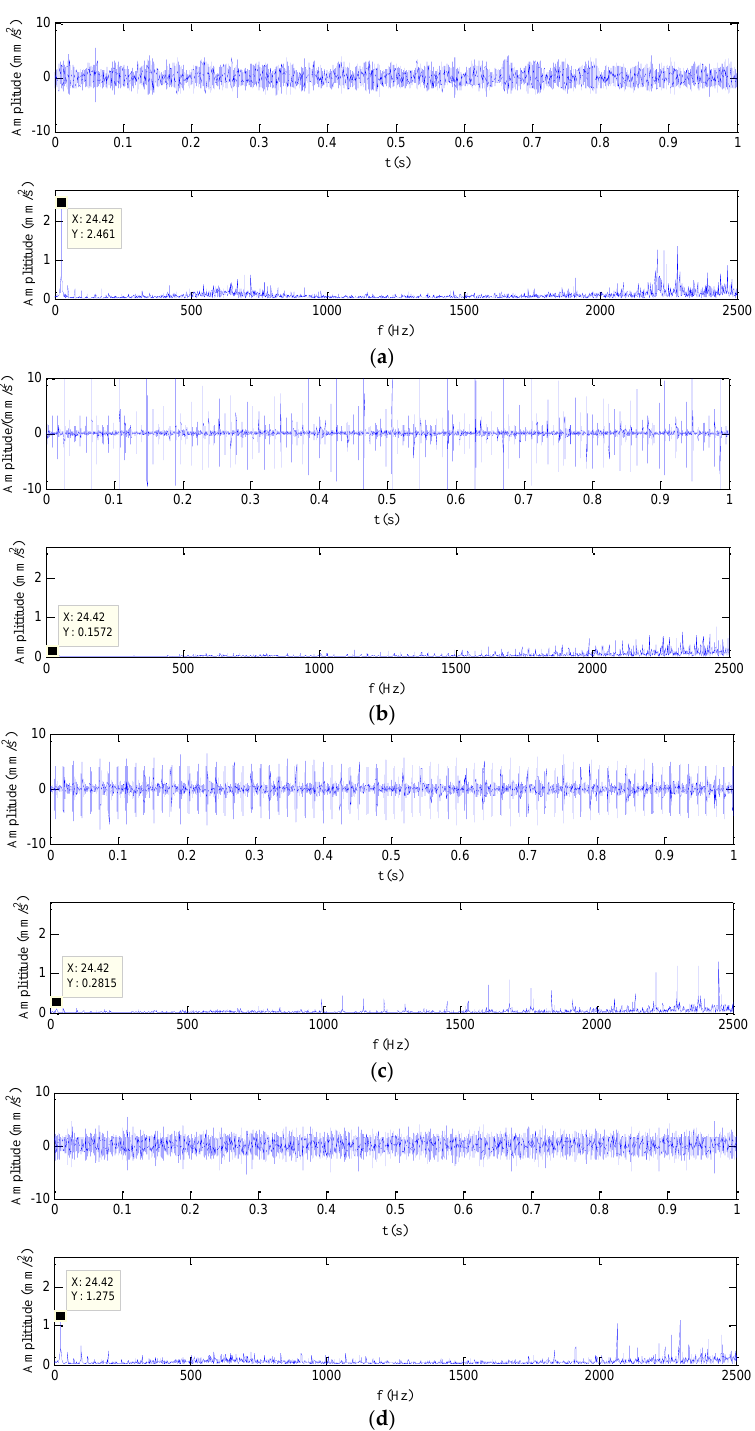
Figure 3. The time domain and frequency domain figures of vibration signals for the four bearing conditions: ( a ) normal condition, ( b ) inner race fault, ( c ) outer race fault, and ( d ) ball fault.